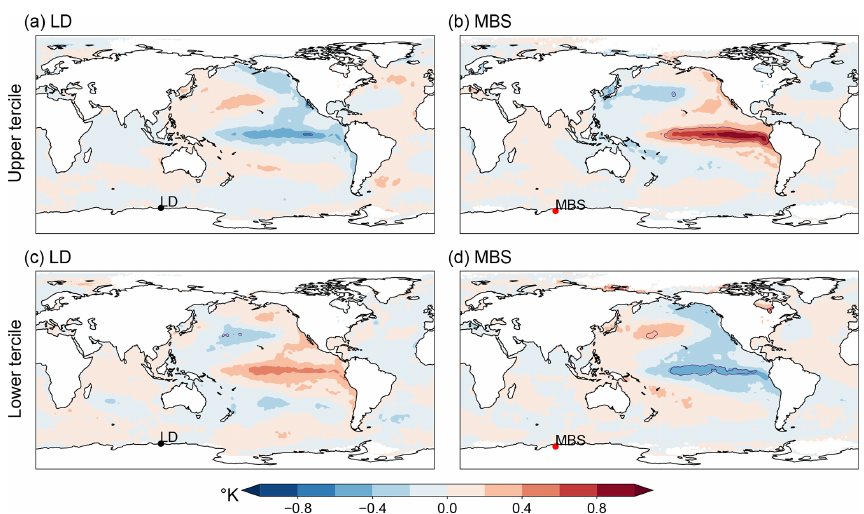
Figure 7. SST anomaly composite maps during the upper (a) and lower (c) tercile (November–February) of the detrended, log-transformed summer sea salt concentrations from the Law Dome (LD, Dome Summit South site) record over 1975–2015, and upper (b) and lower (d) tercile (June–November) detrended, log-transformed sea salt concentrations from the annual Mount Brown South (MBS) site average over 1975–2016. The red dot indicates MBS, and the black dot indicates LD. Significant anomalies are within the upper and lower purple contour lines, where p < 0.1.